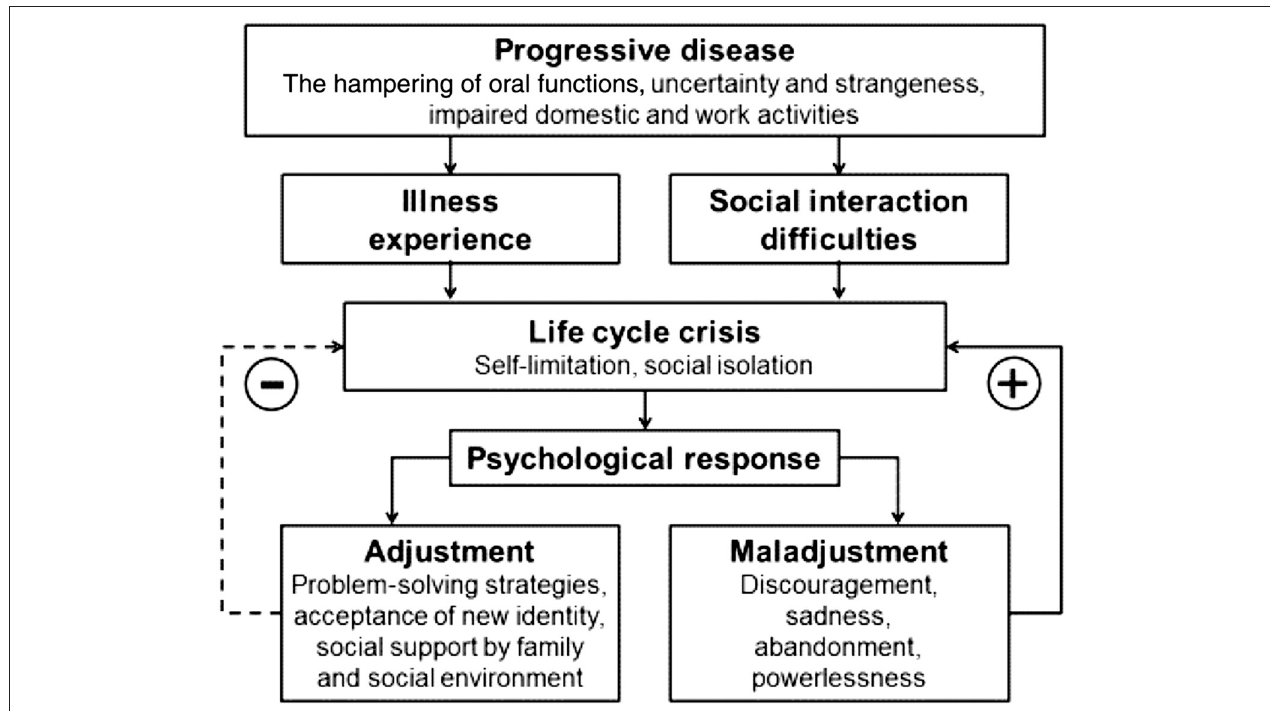
FIGURE 1 | The integrated model summarizing the life experiences of women with primary SS and health-related behaviors